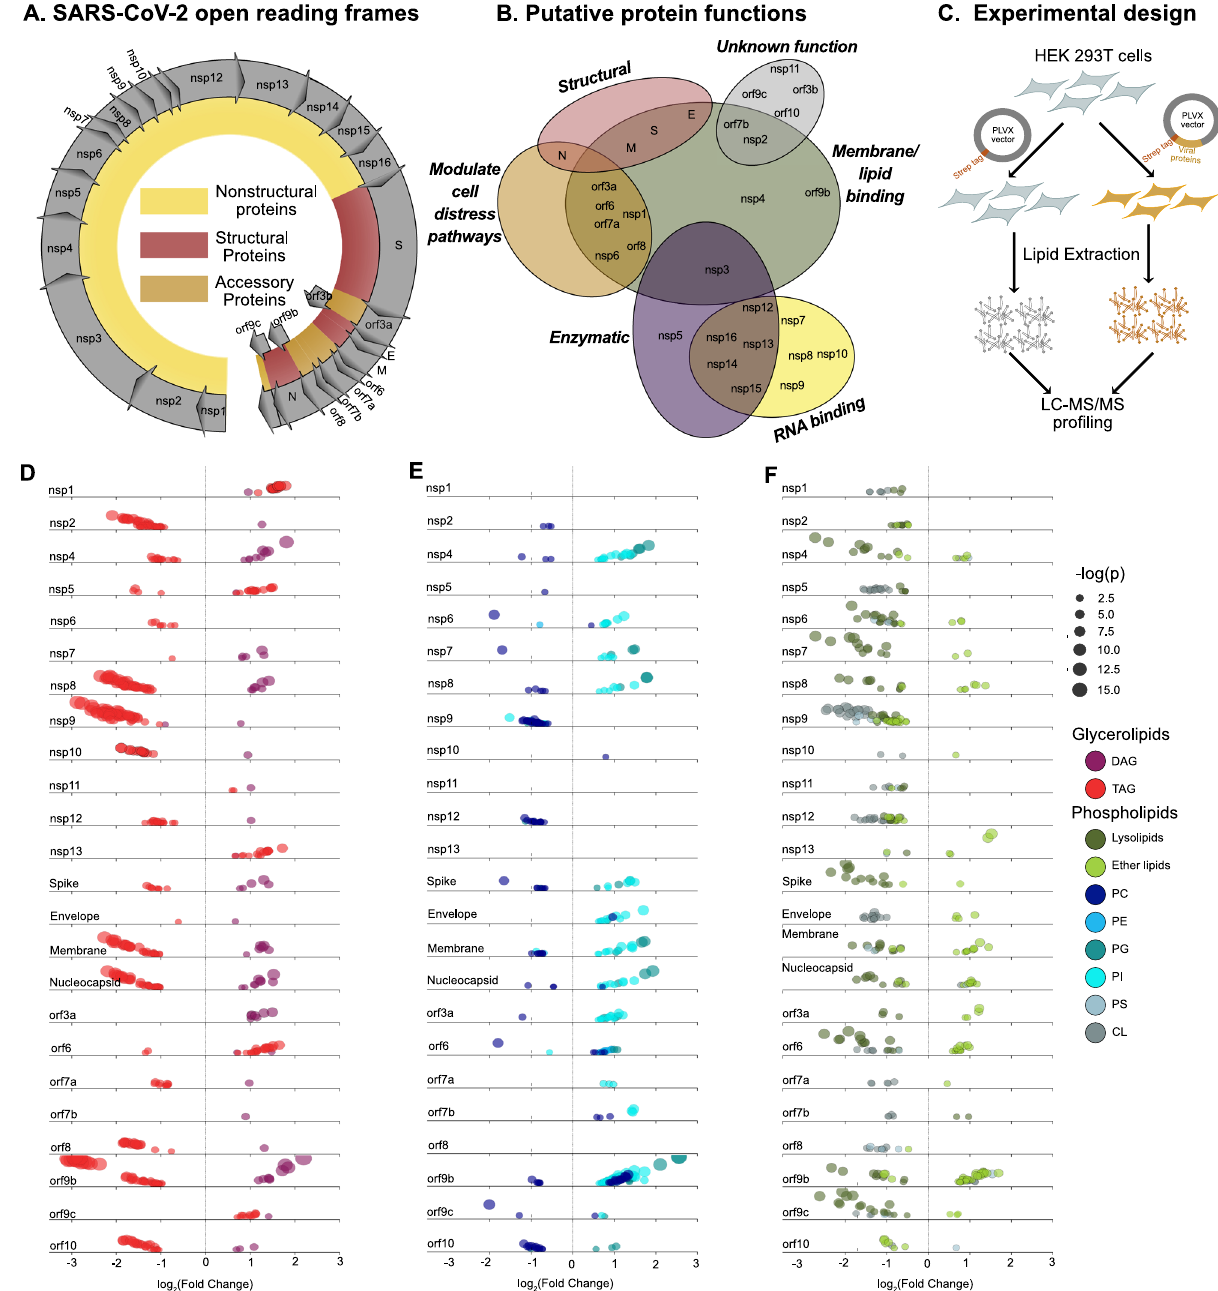
Fig. 2 Ectopic expression of SARS-CoV-2 proteins modulates host lipid metabolism. A Open reading frames of the SARS-CoV-2 genome. B Putative functions of SARS-CoV-2 proteins, based on early studies and sequence similarity to proteins from SARS-CoV. C Lipidomics study design. D – F Individual lipid species characterized by class and family (data points are means from fi ve biological replicates; each data point represents a lipid species). Only signi fi cantly changed ( P < 0.05, one-way ANOVA, Benjamini – Hochmini adjusted for multiple comparison) lipids are shown. Log 2 (Fold Change) relative to empty vector is shown on the x -axis. Individual lipid species are colored by the class of lipid that they belong to. Abbreviations same as Fig. 1. Source data are provided in Supplementary Data